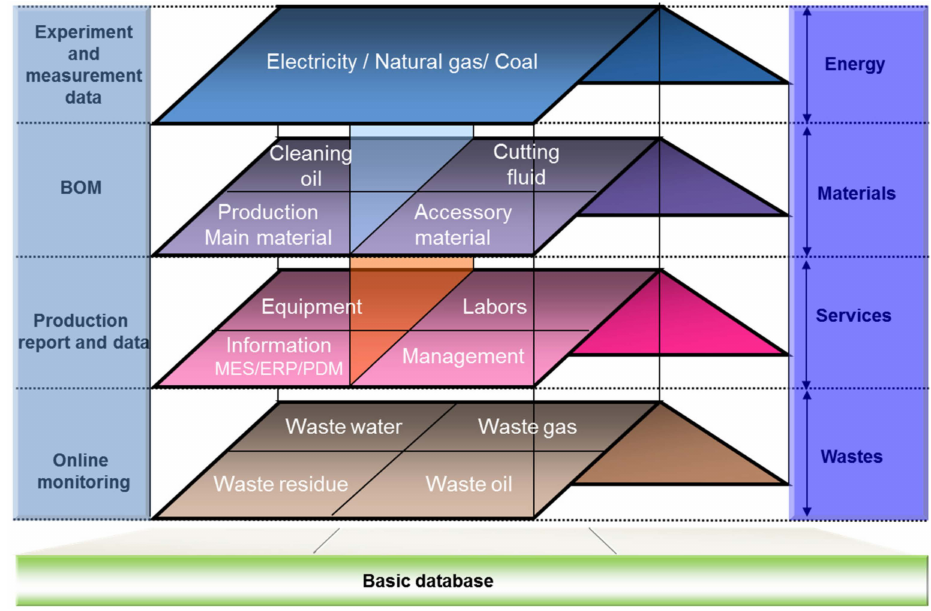
Figure 2. Basic database of machining